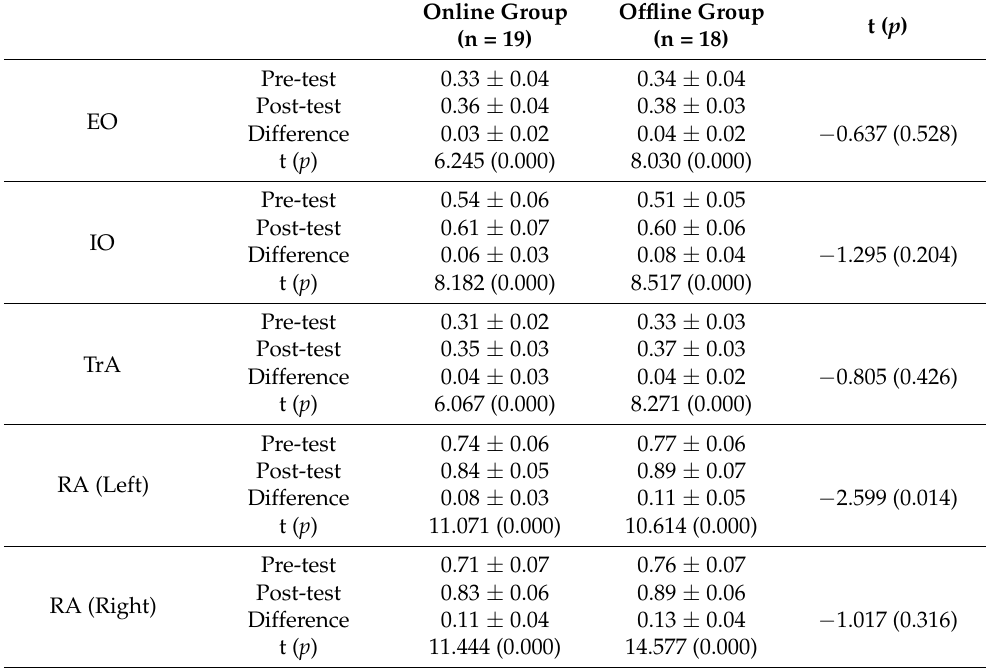
Table 3. Abdominal Thickness (cm) (N =